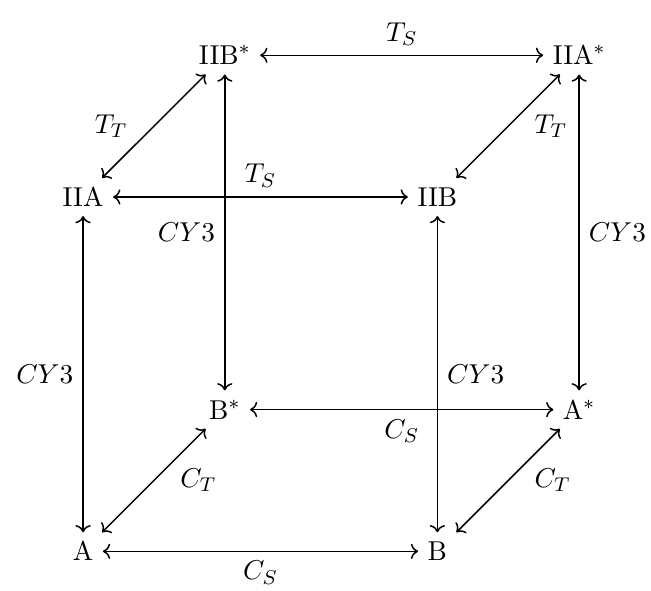
Figure 2 . The spacelike and timelike T-dualities T S , T T between the four type-II string theories in ten-dimensional Minkwoski space induce relations between the four-dimensional supergravity theories, denoted A, B, A ∗ , B ∗ obtained by compatification on the same Calabi-Yau threefold. The number n V of vector multiplets and n H of hypermultiplets is related to the Hodge number of the Calabi-Yau threefold by ( n ) = ( m, n ) = ( h +1) for type-A and ( n ) = ( m 0 , n 0 ) = ( h +1) V , n H 1 , 1 , h 2 , 1 V , n H 2 , 1 , h 1 , 1 for type-B. The theories denoted A ∗ , B ∗ have the same structure, but a modified supersymmetry algebra with a non-compact R-symmetry group which results in sign flips in the Lagrangian and modifications of the scalar geometry. The maps relating the four-dimensional theories are denoted C S , C T , depending on whether they use a spacelike or timelike reduction and